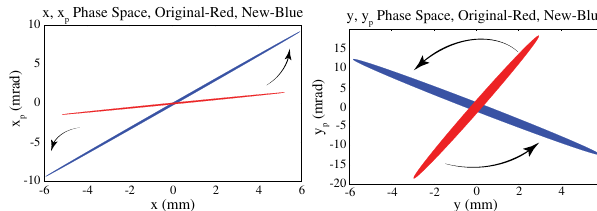
FIG. 13. The input beam was gradually changed over 18000 time steps.